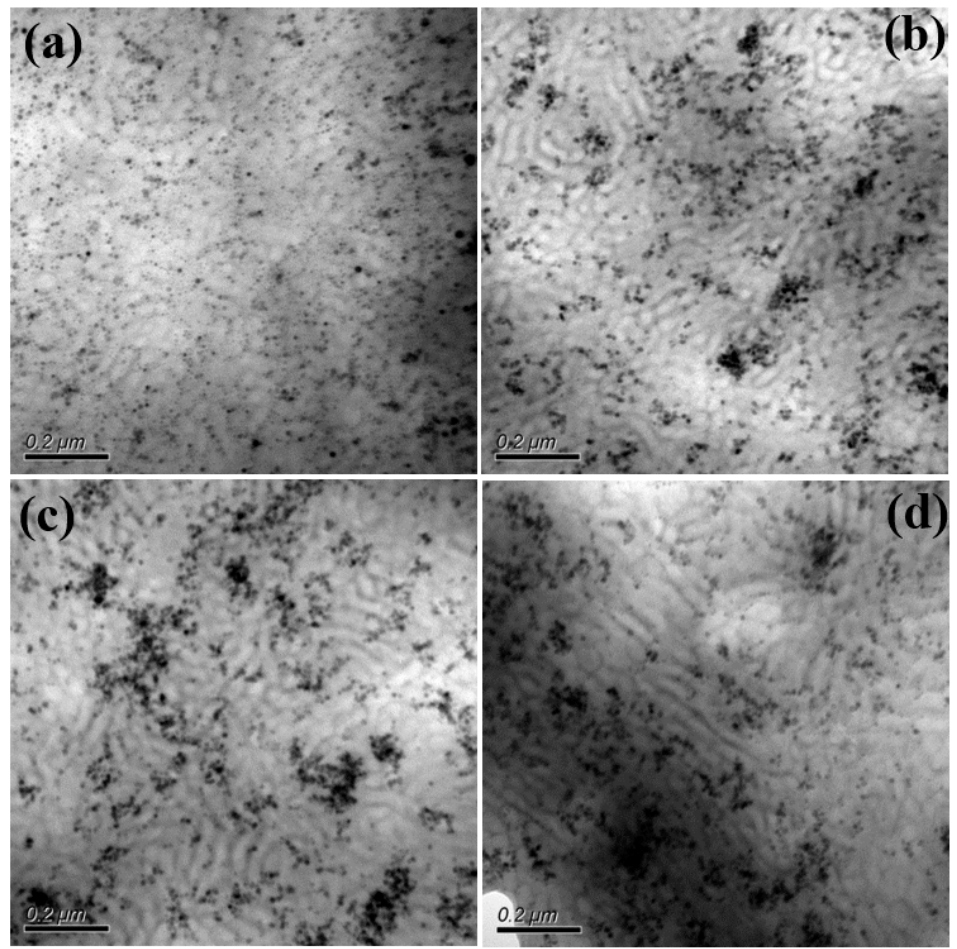
Figure 8. TEM image of S-SEBS polymer with various amounts of TA and Fe 3 O 4 . ( a ) 5 wt.% Fe 3 O 4 and 15 wt.% TA ( b ) 10 wt.% Fe 3 O 4 and 10 wt.% TA; ( c ) 15 wt.% Fe 3 O 4 and 5 wt.% TA; ( d ) 20 wt.% Fe 3 O 4 .